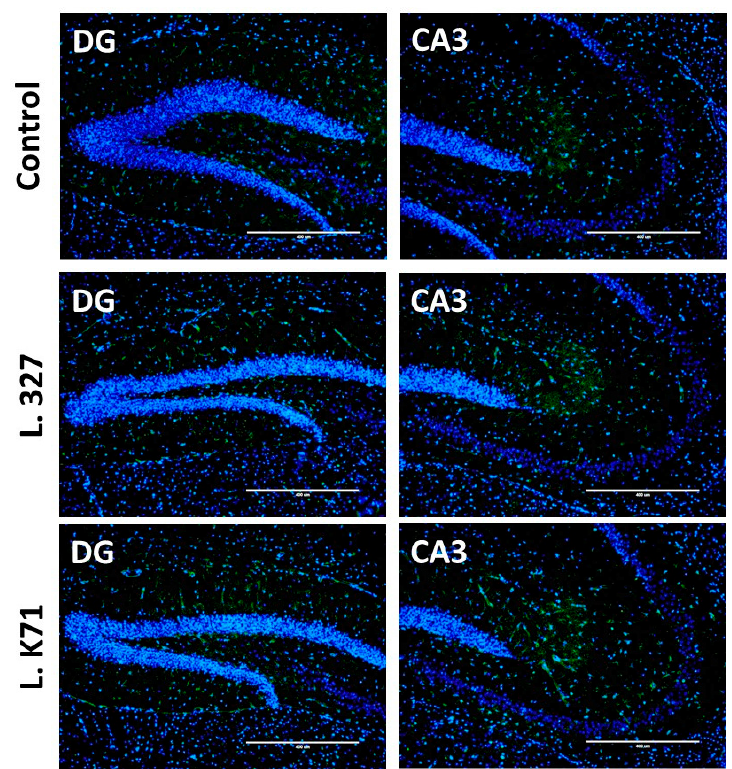
Figure 5. Effects of 43-week Lactobacillus strain administration on the expression levels of brain- derived neurotrophic factor (BDNF) in the hippocampus and cortex of SAMP8. ( A ) Bdnf mRNA levels measured by quantitative PCR ( n = 8 mice per group); ( B ) Western blotting analysis ( n = 4 mice per group) of the protein levels of BDNF; ( C ) Quantification of band intensities in ( B ). Data are expressed as mean ± SEM, * p < 0.05 vs. the control group.